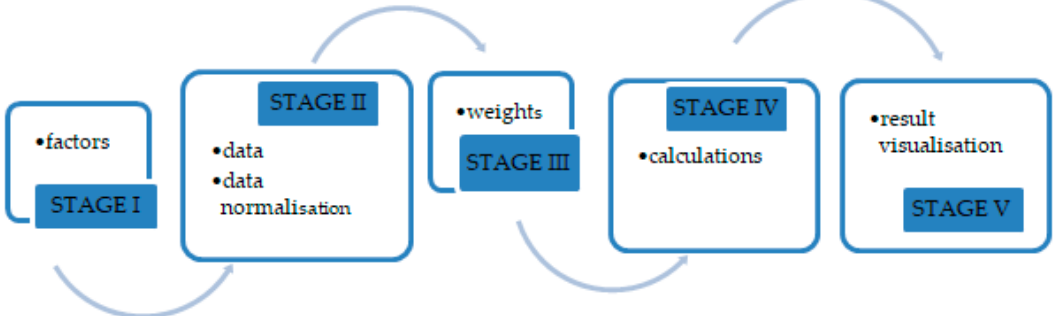
Figure 3. Algorithm of the data use, contained in spatial information systems, for the rating of the selection of municipal waste incineration plant location - research work stages.